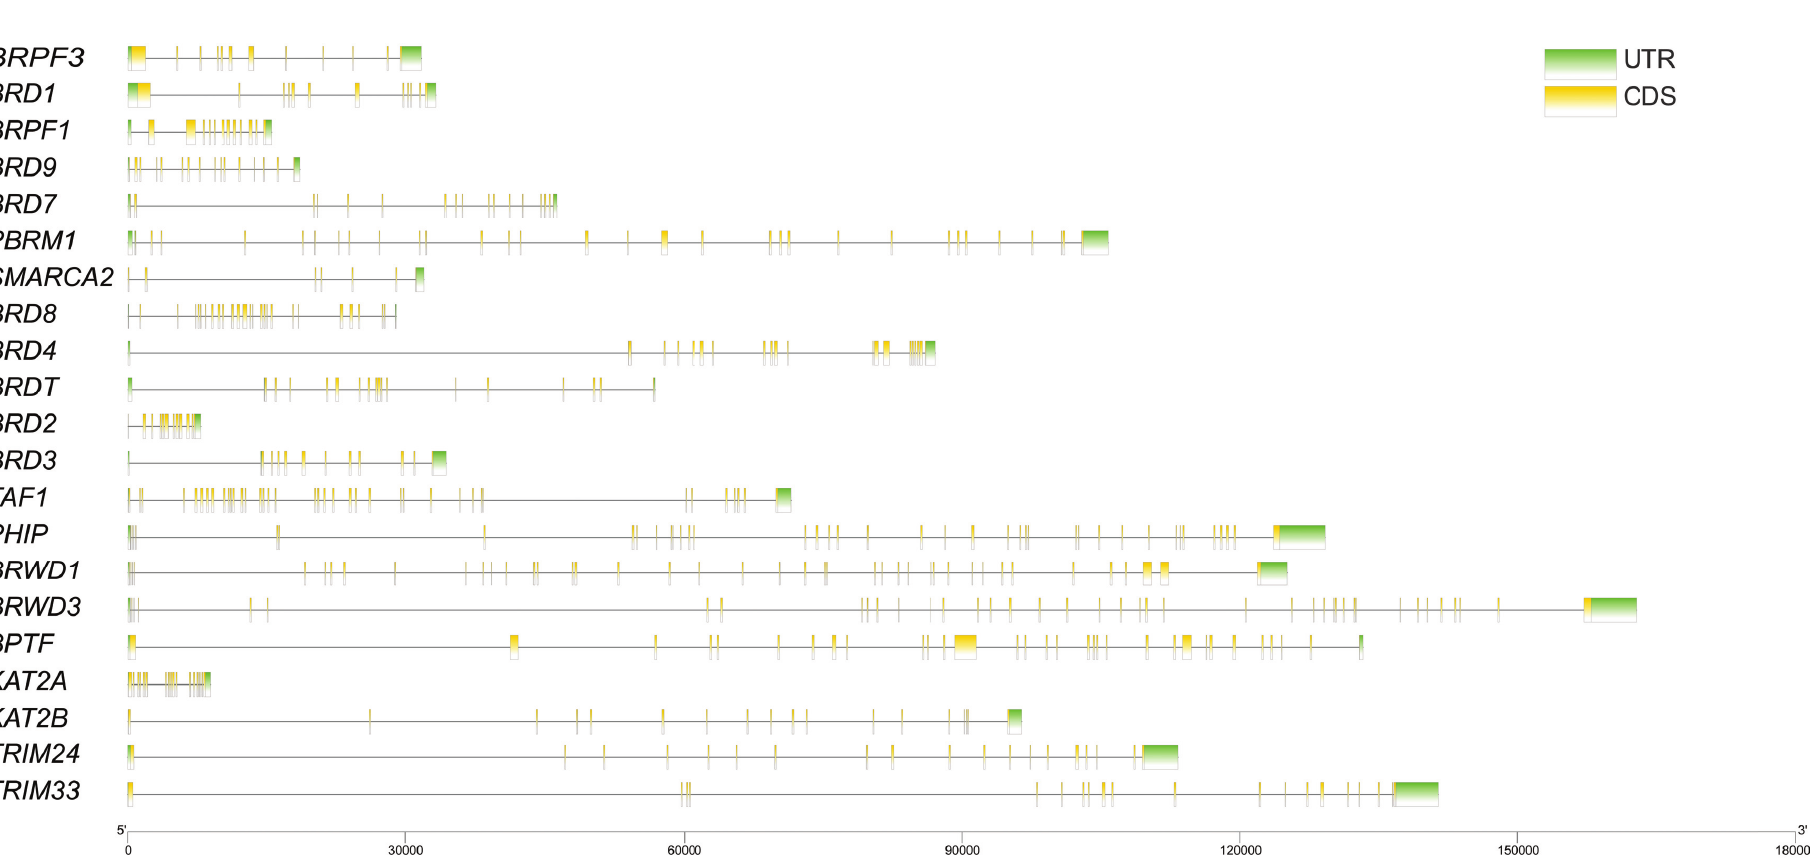
Figure 3. The UTR/CDS structure of BRD genes in buffalo. The green box, black line, and yellow box represent UTR, intron, and CDS,